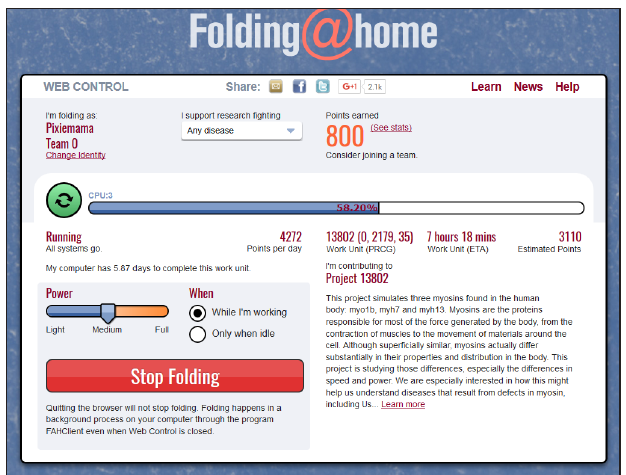
Figure 1: Folding@home progress page. Participants can track the completion of a current project and find more about the scientific aims. They can also select what disease they wish to work on from a pull-down menu (authors own